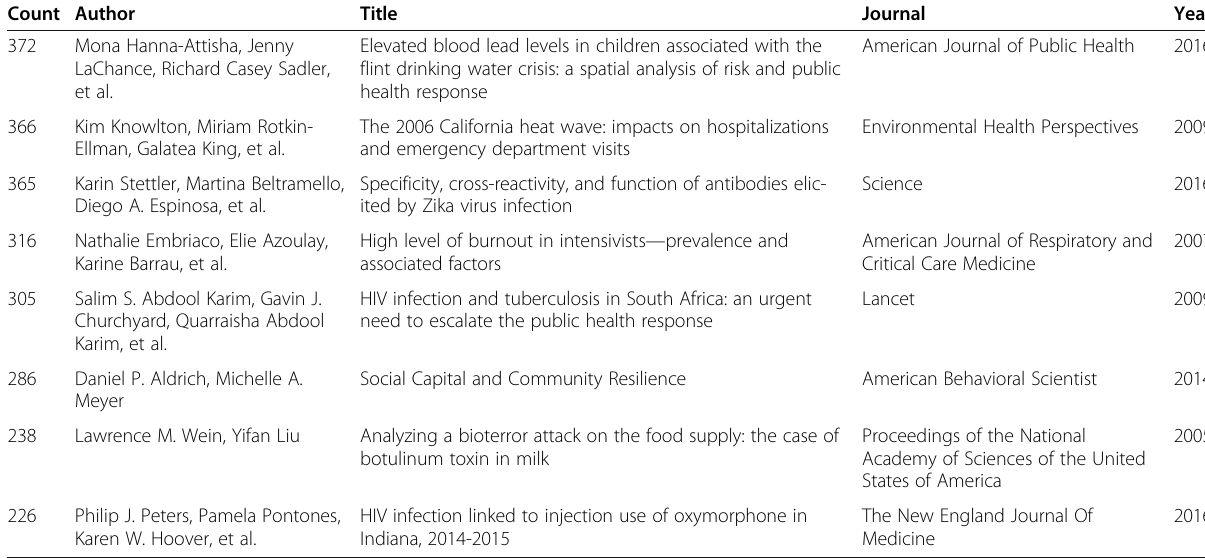
Table 2 Top 8 cited articles of international